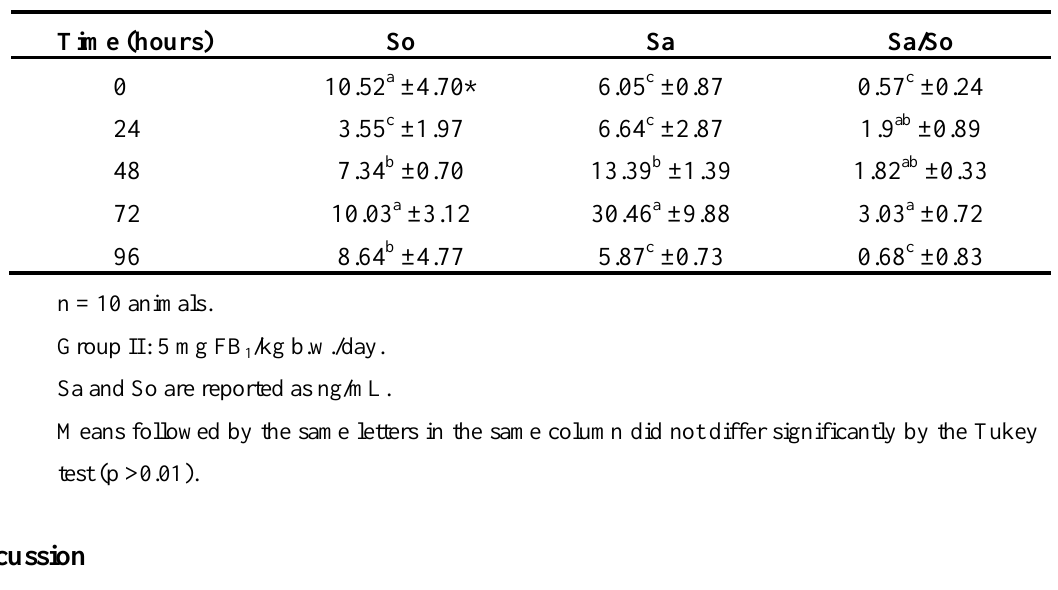
Table 2. Mean sphingosine (So) and sphinganine (Sa) levels and urine Sa/So ratio in rats receiving a single dose of FB 1